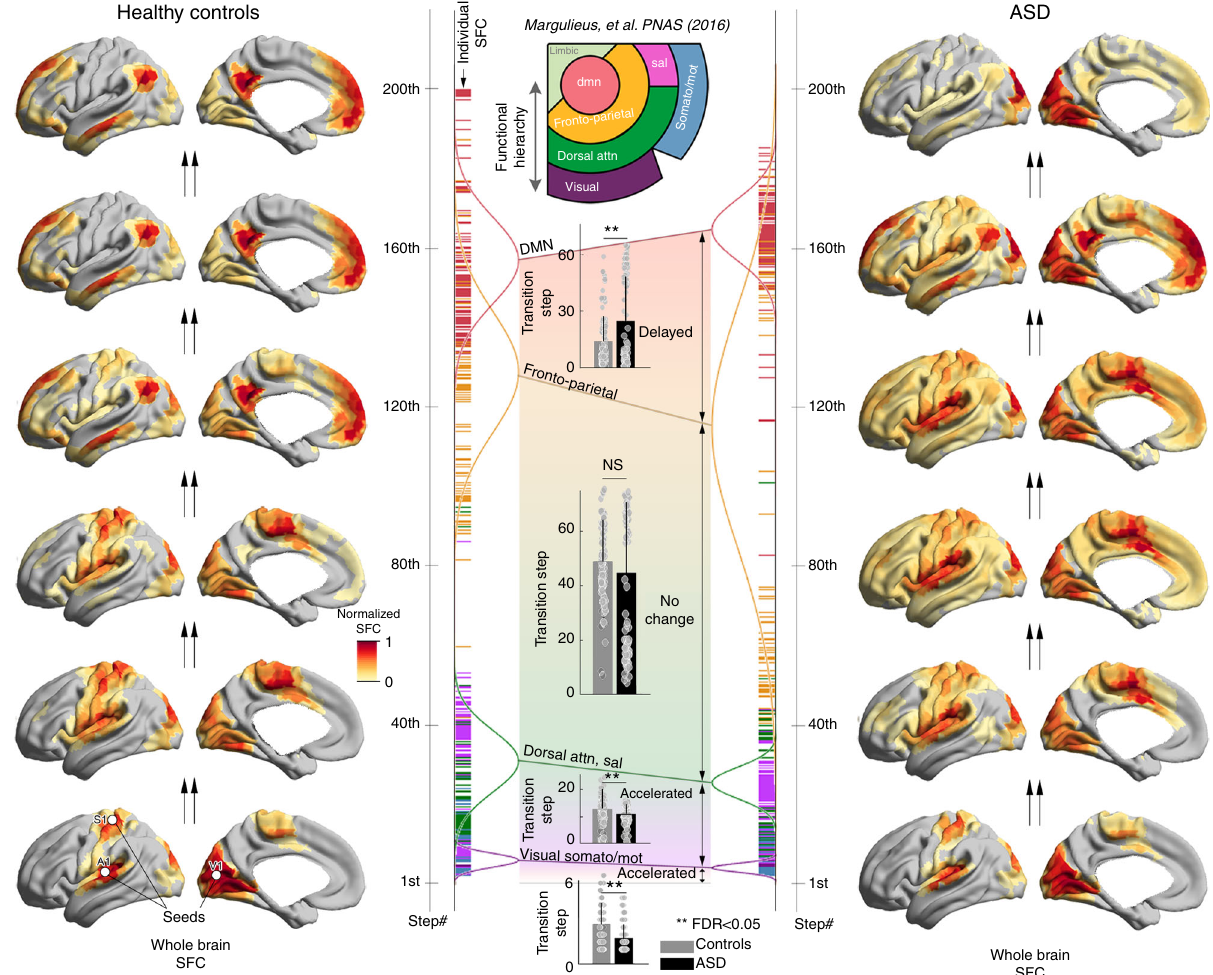
Fig. 2 Stepwise functional connectivity (SFC) analysis. SFC analysis combining three sensory seeds simultaneously (V1, A1, S1) mapped the human multimodal integration network in controls (left) and ASD (right). The number of connectivity steps increases moving up in the plot. In controls, transmodal DMN regions became selectively activated, after around 100 – 120 steps. In ASD, despite rapid initial activation of a rather extended territory, a selective DMN core activation did not occur in a comparable step range as in controls. The middle panel shows SFC fi ndings strati fi ed across four hierarchy levels, adapted from Mesulam 8 and Margulies et al. 17 . The bar represents a mean ± 1 SD of required connectivity steps. Statistical comparisons between groups using Student ’ s t -tests across these four levels emphasize faster SFC to sensory, dorsal attention, and salience networks in ASD compared to controls, but delayed SFC to the